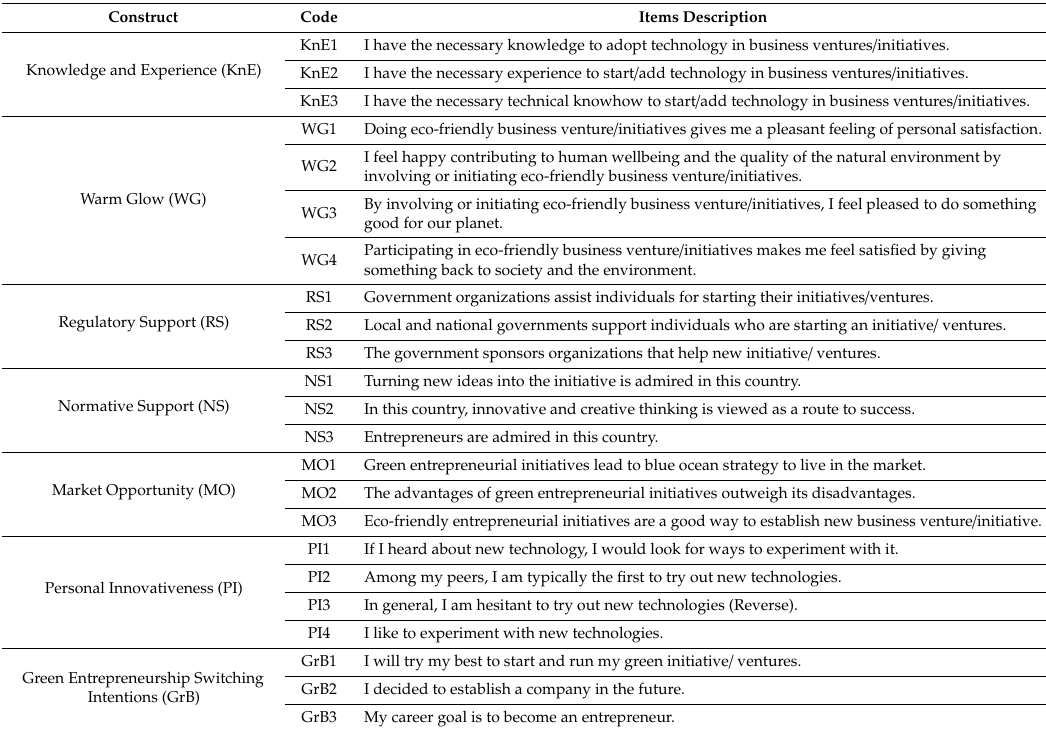
Table 1. Constructs, instruments, and sources.